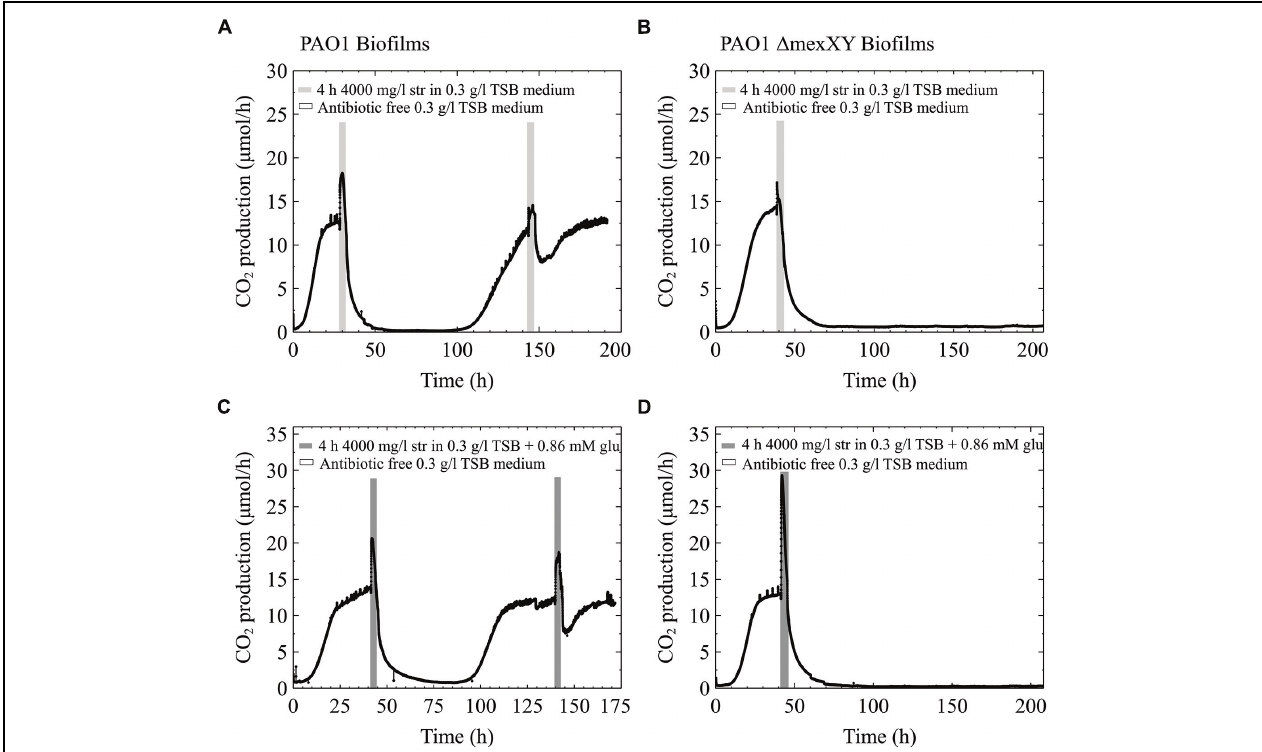
FIGURE 6 | Effect of inoculum – the experiments shown in Figure 5 were repeated, with the only exception that the cultures used for inoculation were first streak plated prior to growing overnight cultures. All other information as described in Figure 5 .